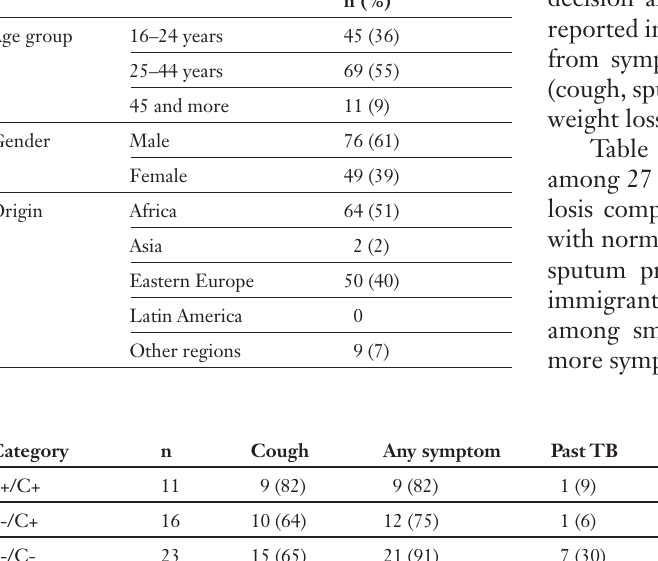
Symptoms and his- tory of TB among 125 immigrants with ab- normal CXR, by final diagnosis (S+/C+: smear-positive TB, S-/C+: culture-posi- tive TB, S-/C-: culture- negative TB, and fi- brotic lesions). Any symptom is a posi- tive answer to at least one of the ques- tions about cough, sputum production, fever, night sweating or weight loss. Absolute numbers with % in